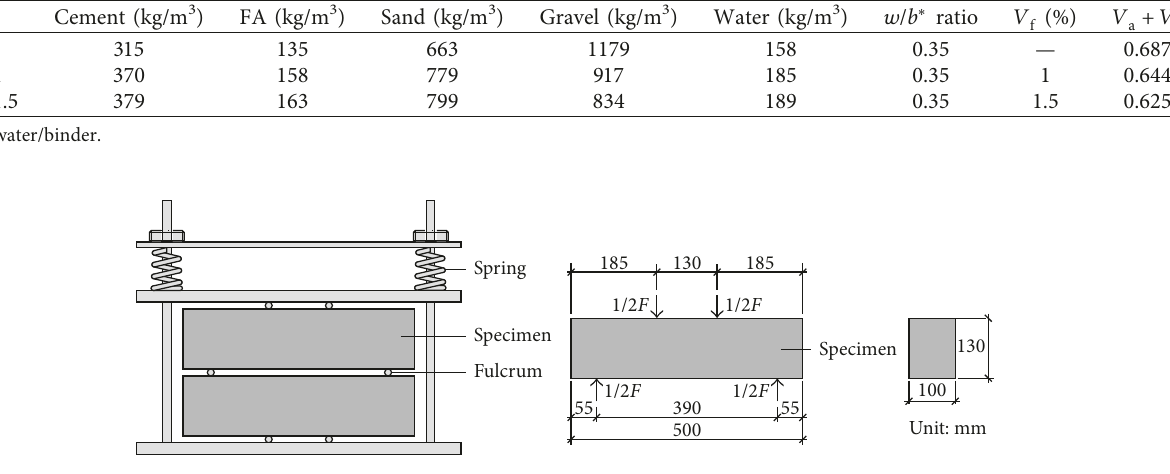
Figure 1: Loading device for the chloride bulk diffusion test. Table 2: Flexural strength and bending load (at a stress level of 0.5) at 90